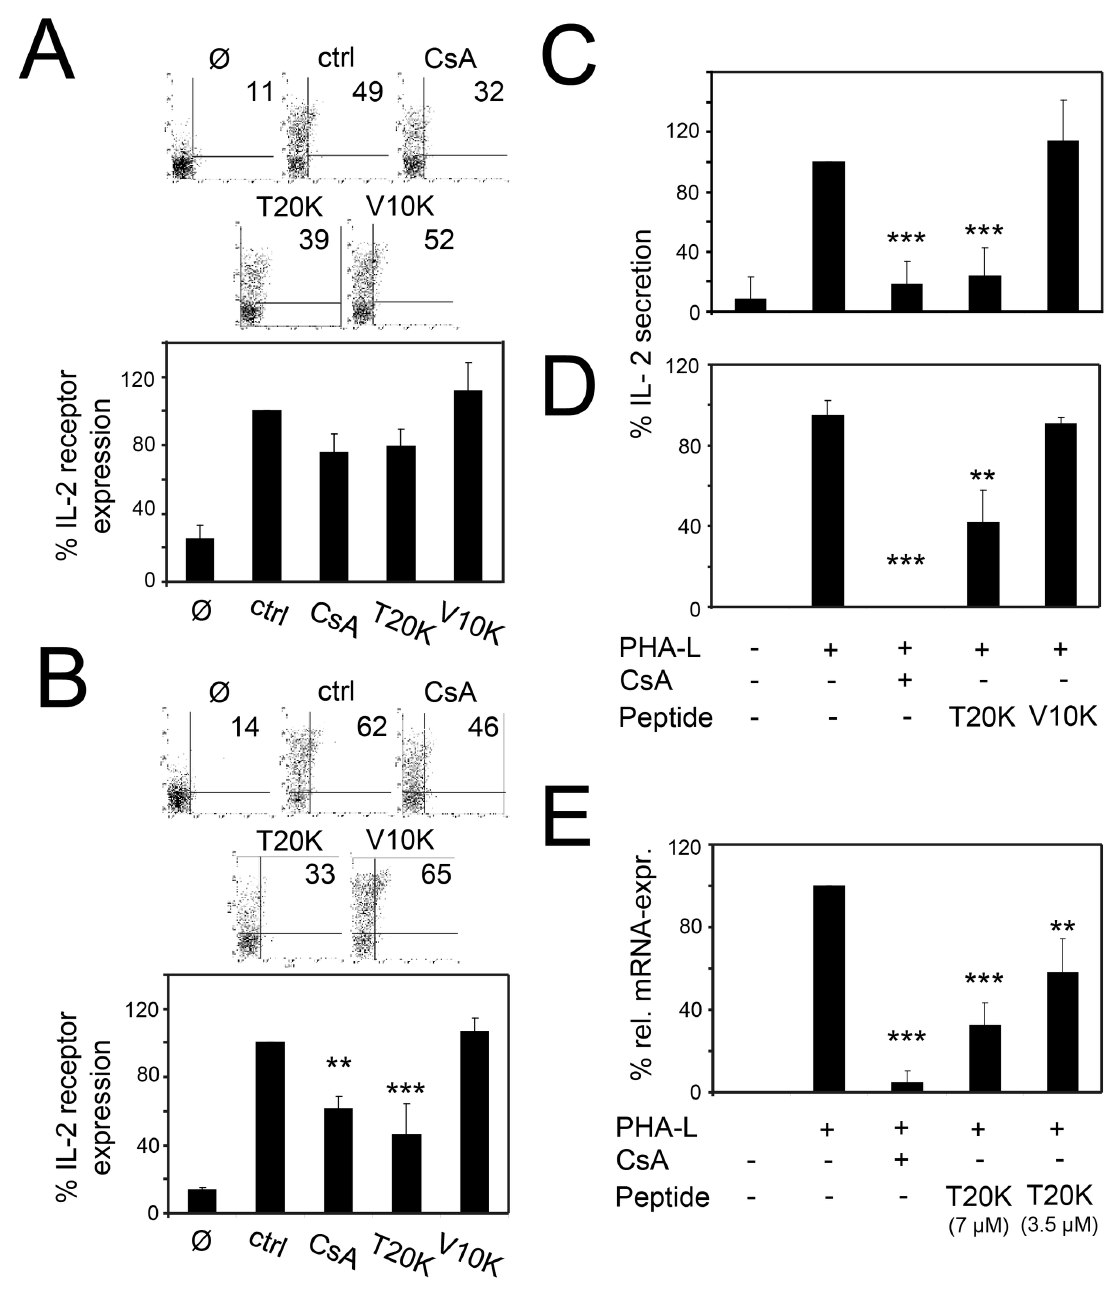
Figure 3. Effects of cyclotide mutants on IL-2 biology of primary activated human lymphocytes and purified T-cells. For IL-2 receptor expression studies, lymphocytes were treated with CsA or cyclotides (4 µM each) and were cultivated in the presence of media (Ø) or activation stimuli alone (ctrl). At 24 h ( A ) or 36 h ( B ) after cultivation, cells were surface-stained with anti-human CD25 mAbs and were analyzed by flow cytometry. For IL-2 secretion analysis, lymphocytes ( C ) or purified T-cells ( D ) were restimulated with PMA (50 ng/mL) and ionomycin (500 ng/mL) for 6 h after 24 h of cultivation. Afterwards, the amount of IL-2 was individually measured in the supernatant by using ELISA-based techniques. The il-2 gene expression of lymphocytes was analyzed by quantitative RT-PCR ( E ). The data were normalized to the cycle threshold value of the internal housekeeping gene 18s rRNA and the relative mRNA level in the untreated stimulated group was used as calibrator. Data are expressed as mean ± SD of independent donors and experiments as indicated. For IL-2 receptor analysis representative data were additional depicted as dot plots. The asterisks represent significant differences (* P <0.05, ** P <0.01, *** P <0.001) of treated cells in comparison to ctrl (PHA-L stimulated cells alone). doi: 10.1371/journal.pone.0068016.g003 PLOS ONE |